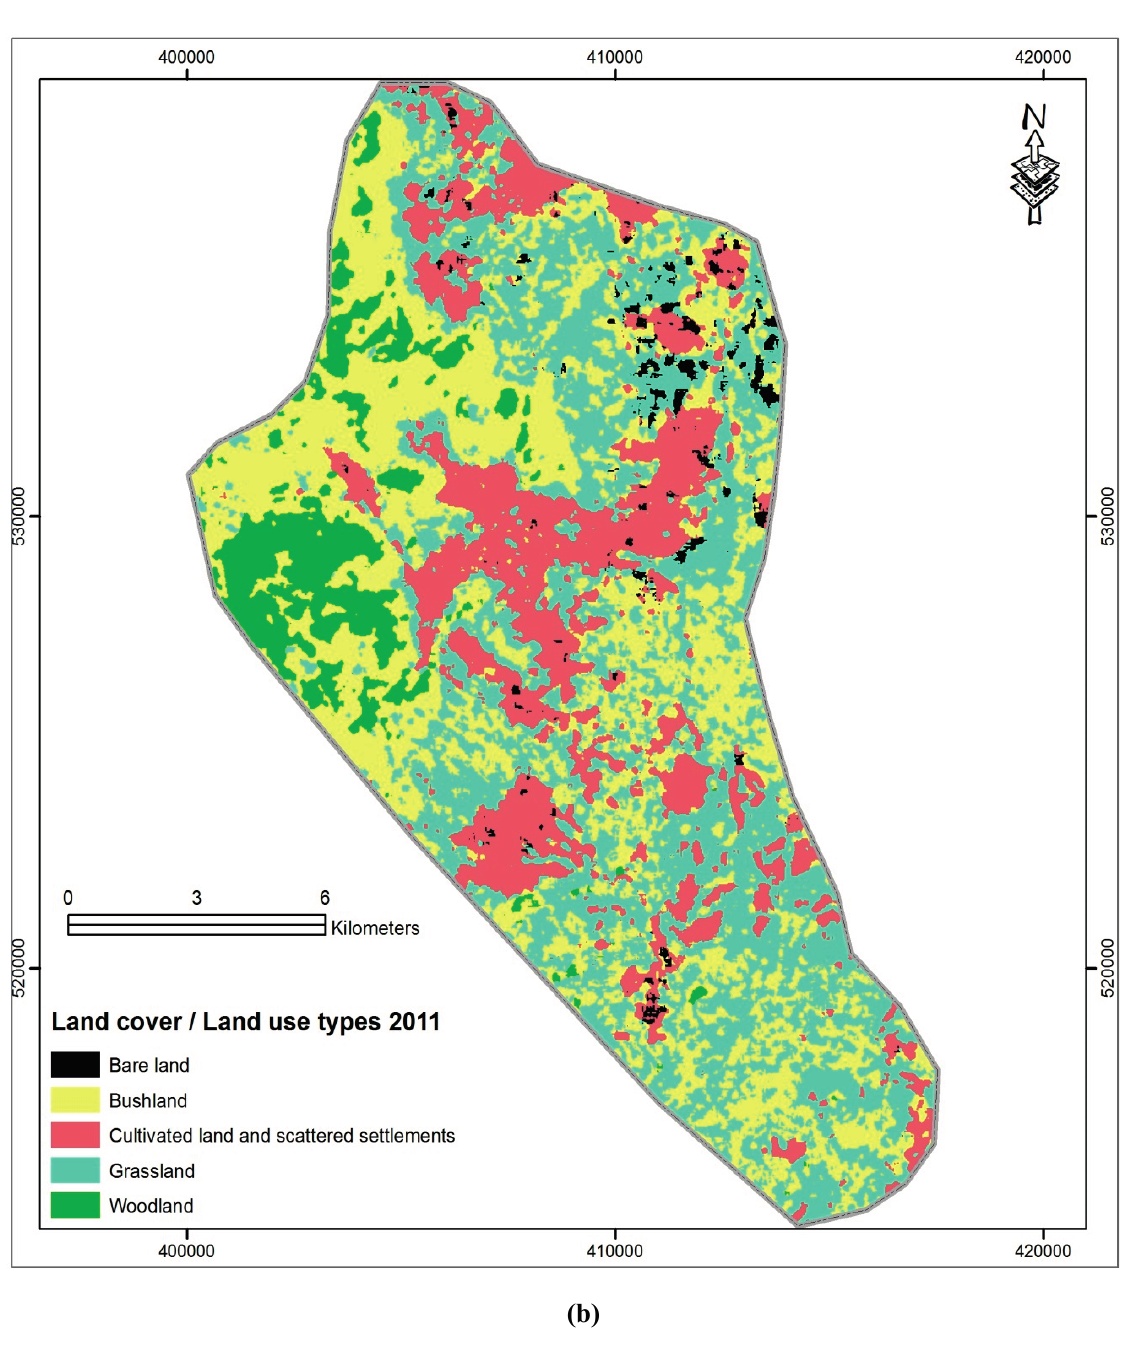
Figure 2. Land cover classes and land cover changes in Darito between 1985 ( a ) and 2011 ( b